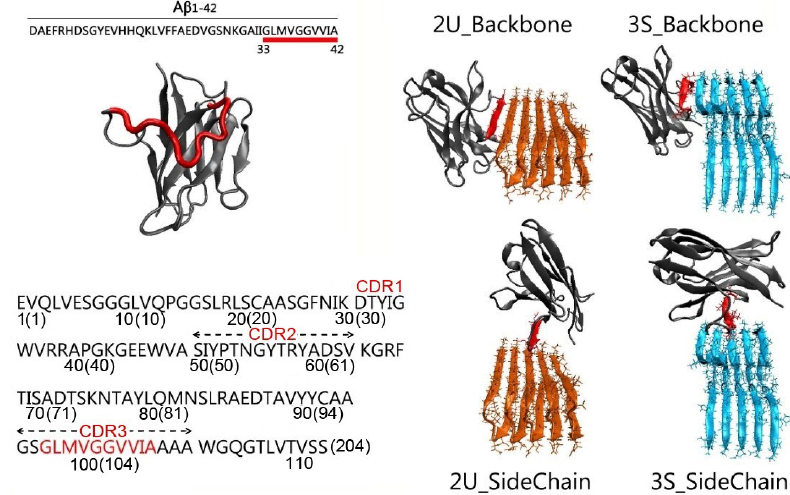
Figure 1. Structures and sequences of the gammabody, A β and their complexes investigated. Color Code: grafted A β residues in gammabody (red), the gammabody scaffold (gray), 2U A β aggregates (orange), 3S A β aggregates (cyan). The complementarity-determining regions (CDRs) are defined using Kabat numbering, the consecutive numbers are indicated in parenthesis. Two A β conformations are considered here: 2U A β model comprising two parallel β -sheet strands connected by one turn region, forming a U-shape conformation, and the 3S A β model with three parallel β -sheet strands bridged by two turn